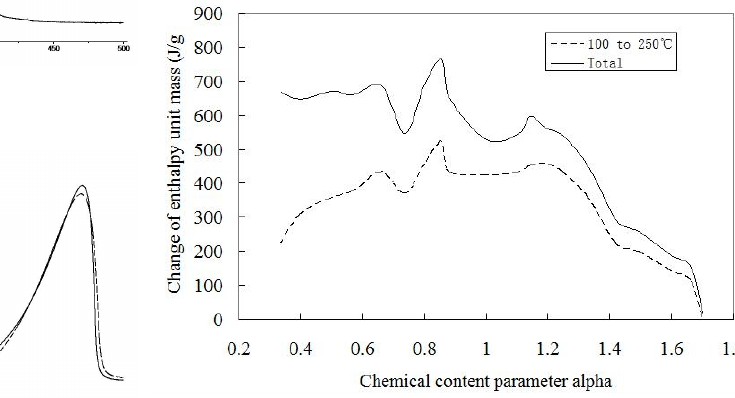
From Fig. 7, if the high temperature steam at 510 ∘ is allowed to escape to the atmosphere, instead of storing in the vapor phase, an additional heat energy of 61.5 kJ is lost. In this case, a total of 57.2% (23.5+61.5=85.0 kJ) of the input energy is released, which results in a loss of the sensible heat of the products. The actual remaining energy is only 42.8% (63.6 kJ), which is stored in the form of chemical